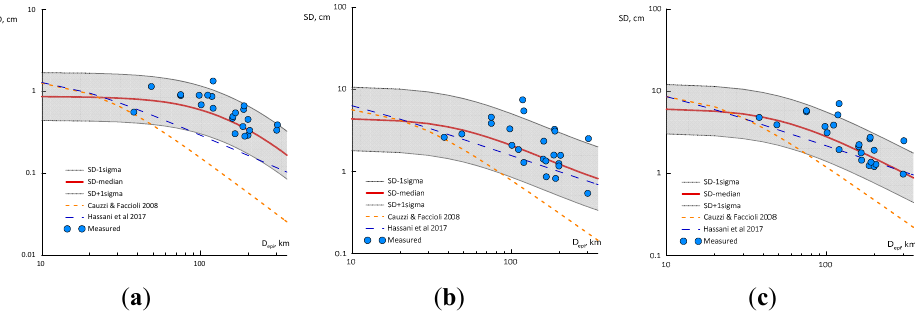
Figure 22. Attenuation of the model with distance and comparison with other models, type B soil, set 3. ( a ) T = 0.30 s; ( b ) T = 1.00 s; ( c ) T = 1.50 s.